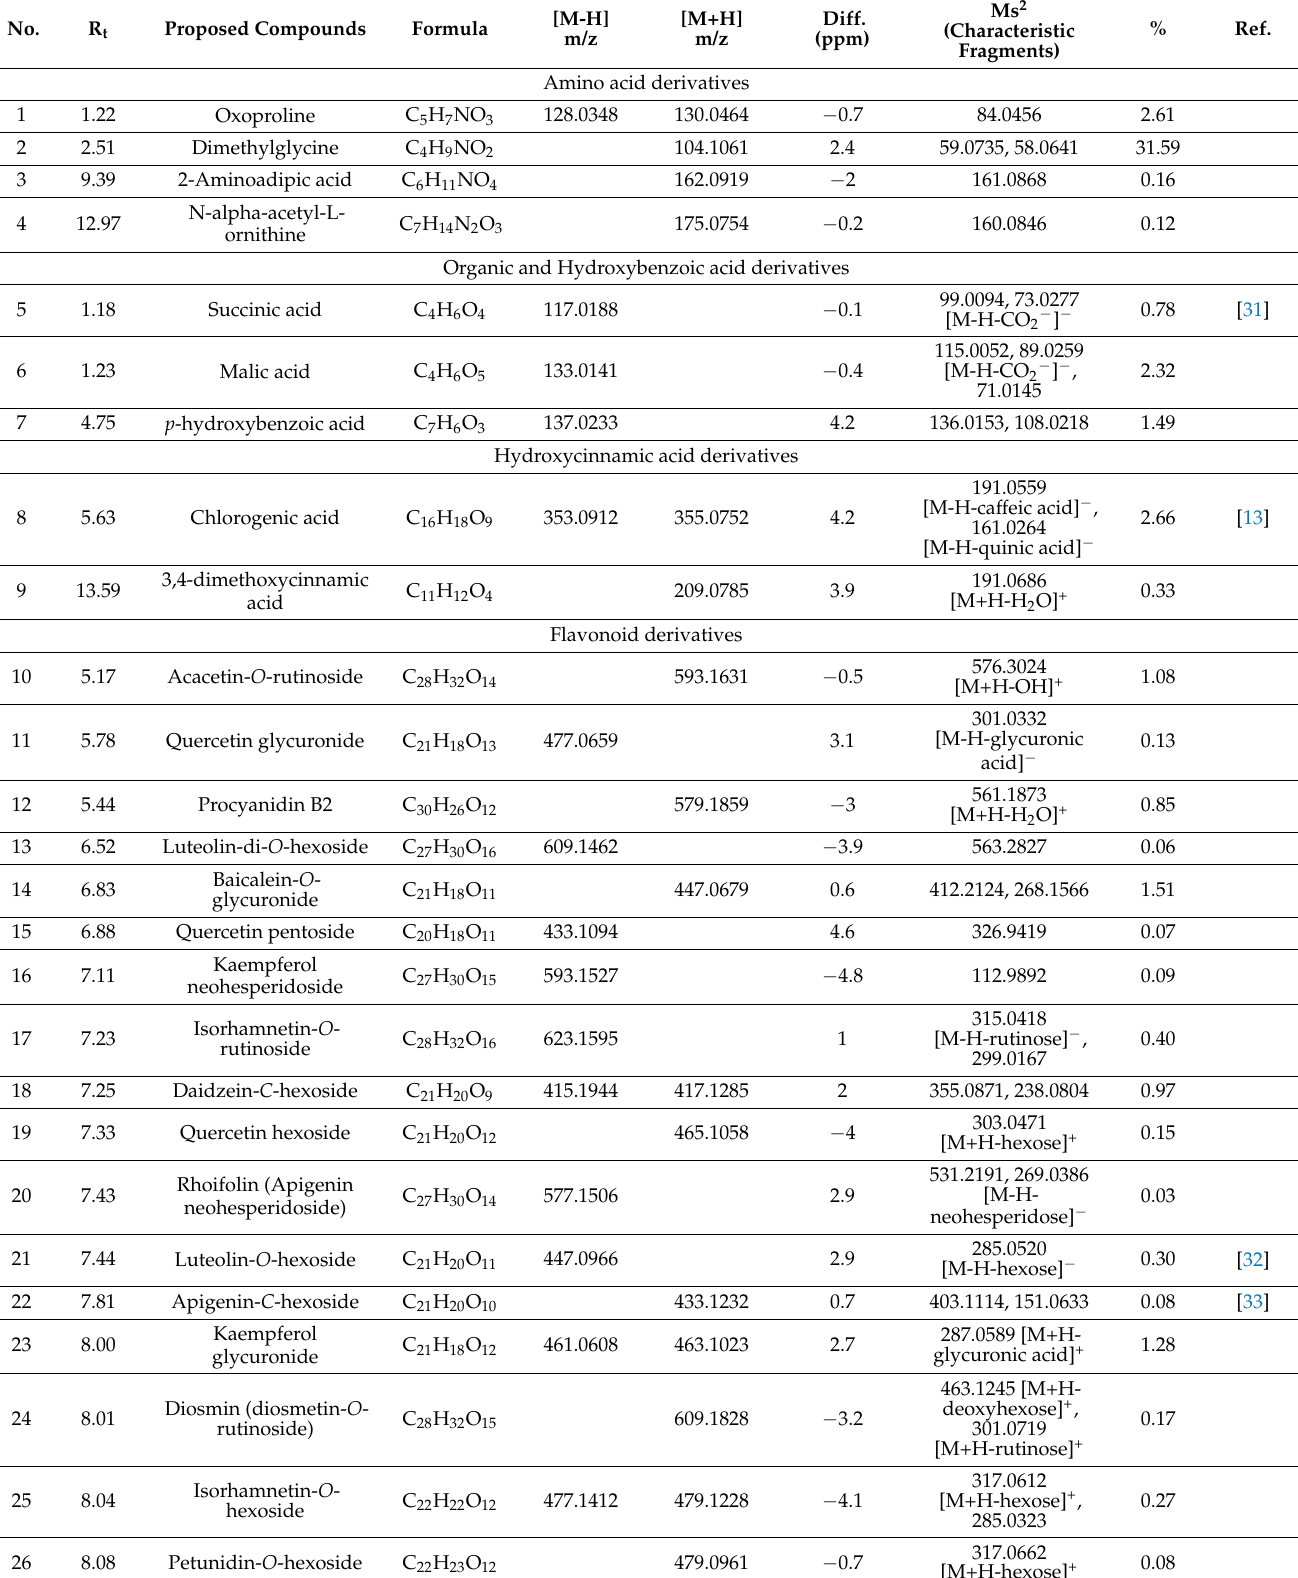
Table 2. Tentatively identified metabolites via UPLC/T-TOF–MS/MS in the methanol extract of Saussurea costus roots using negative and positive ionization